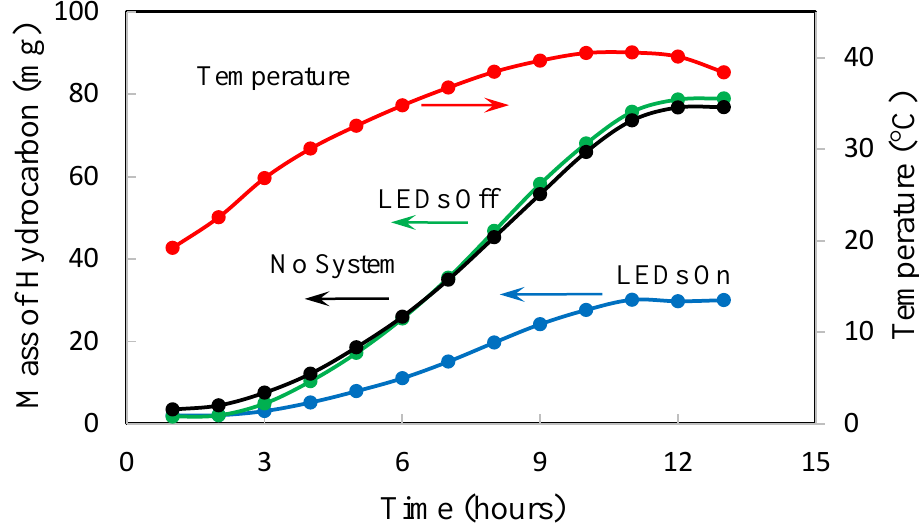
Figure 4. Results from standard evaporative fuel vapor emissions tests.